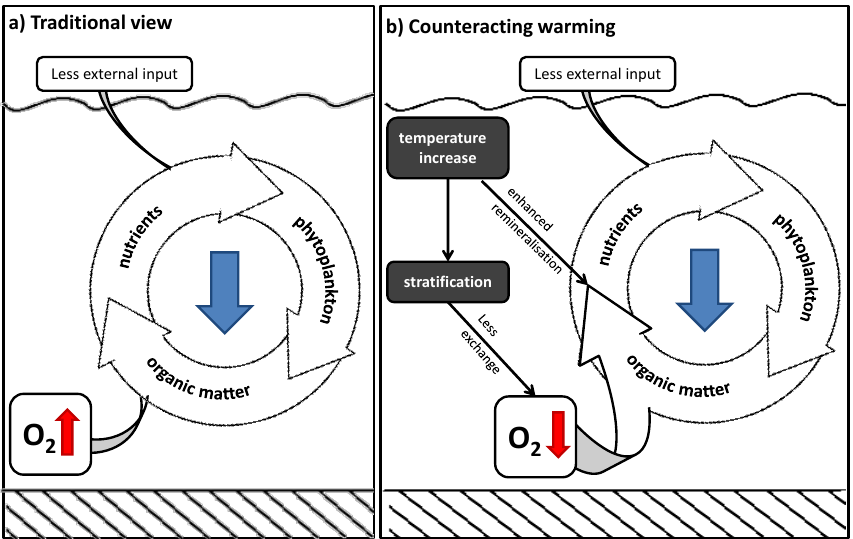
Figure 9. Schematic overview of possible causes for ongoing oxygen decline. (a) The traditional view of declining eutrophication: decreasing nutrient input, less phytoplankton and less organic matter (blue downward arrow) leading to less oxygen consumption and thus rising oxygen concentration (red upward arrow). (b) Alteration by warming temperature (dark grey): on the one hand, rising temperature enhances remineralisation and thus increases oxygen consumption; on the other hand, it increases stratification stability and hampers oxygen supply from surface waters. As a result, oxygen concentration decreases (red downward arrow).